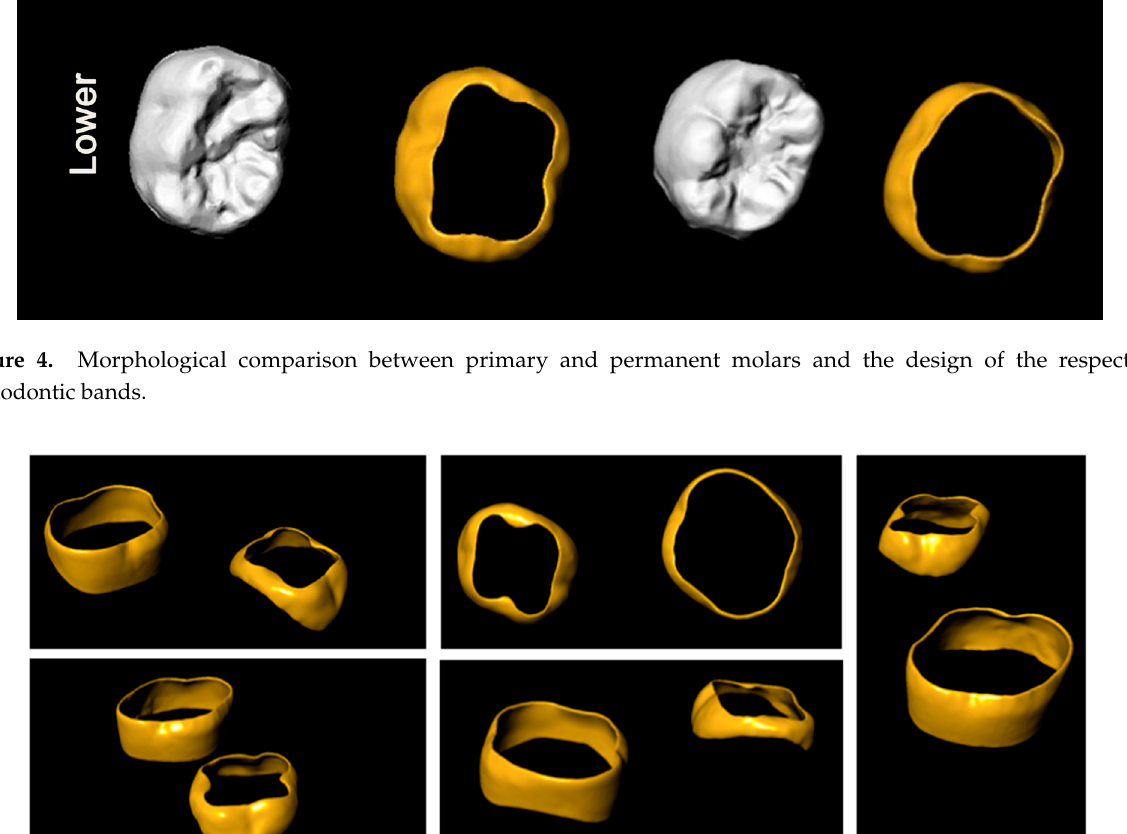
Figure 5. Multiperspective comparison between the proposed design of orthodontic bands for (upper and lower) primary and permanent molars.